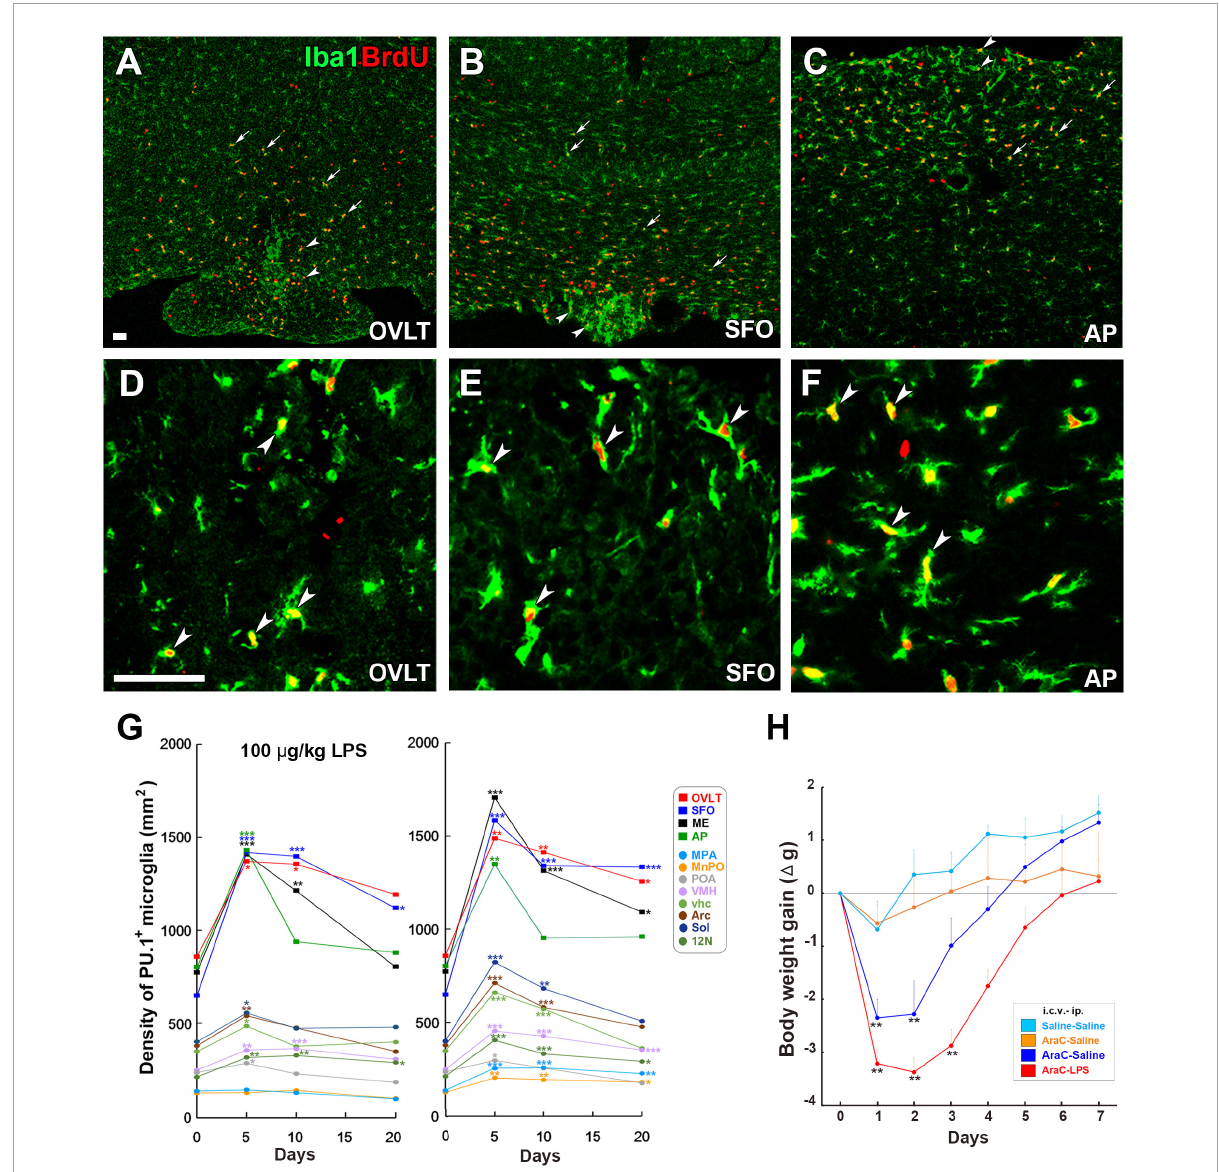
FIGURE6 Remarkable increase in proliferation of microglia and macrophages in the CVOs and neighboring brain regions in adult mouse brain after LPS administration. Intraperitoneal administration of 100 µ g/kg LPS induces a robust increase of Iba1 + BrdU + proliferating microglia and macrophages in the OVLT (arrowheads) and medial preoptic area (MPA; arrows) (A) , the SFO (arrowheads) and ventral hippocampal commissure (vhc; arrows) (B) , and the AP (arrowheads) and solitary nucleus (Sol; arrows) (C) . High magnification reveals many Iba1 + BrdU + proliferating microglia and macrophages in the CVOs (D–F) . Scale bars = 100 (A) and 50 µ m (D) . Photographs are rearranged with permission from Springer Nature (Furube et al., 2015, 2018). The density of PU.1 + microglia and macrophages is significantly elevated in the CVOs and neighboring brain regions on the 5th and 10th day after administration of 100 µ g/kg and 1 mg/kg LPS, but returns to almost normal levels on the 20th day (G) . The i.c.v. infusion of the mitotic inhibitor AraC significantly delays body weight recovery after 5 mg/kg administration (H) . 10N, dorsal motor nucleus of vagus nerve; 12N, hypoglossal nucleus; AP, area postrema; fi, fimbria; MnPO, median preoptic area; MPA, medial preoptic area; OVLT, organum vasculosum of the lamina terminalis; SFO, subfornical organ; Sol, solitary nucleus; vhc, ventral hippocampal commissure; VMH, ventromedial hypothalamic nucleus. * p < 0.05, ** p < 0.01, *** p 0.001 vs. the control by an ANOVA with Tukey’s post-hoc test. Graphs are rearranged with permission from Springer Nature [ (A) Furube et al., 2018] and Elsevier B.V. [ (B) Torii et al.,